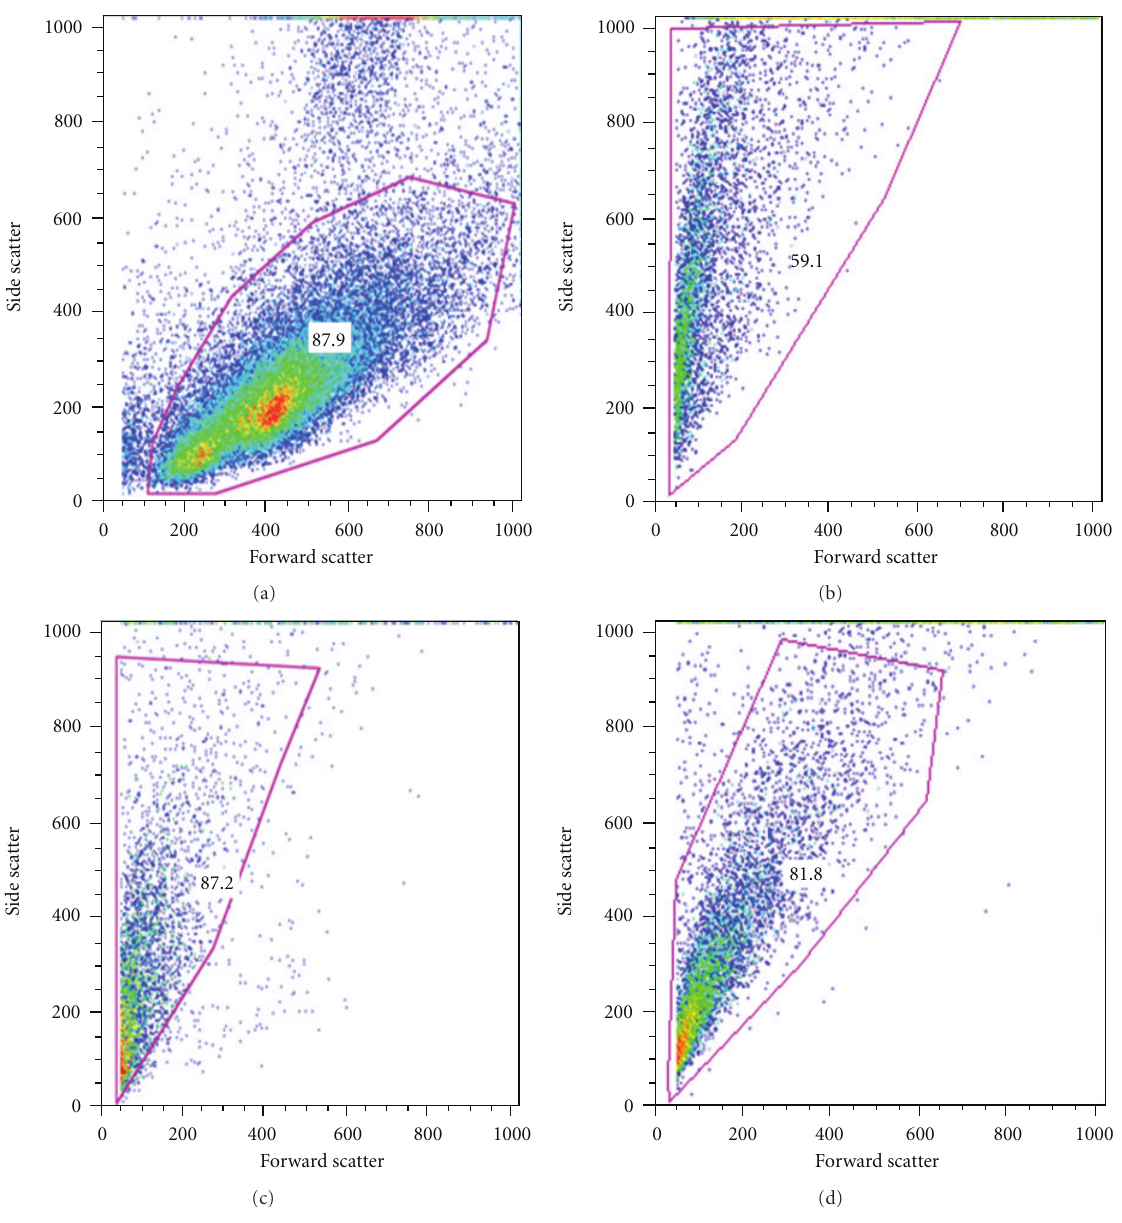
Figure 3: Forward/Side scatter of splenocytes and parasites isolated cells. (a) Spleen cells, (b) T. solium cells, (c) T. crassiceps cells and (d) T. spiralis cells were disaggregated by tissue disruption, washed twice with FC bu ff er, and fixed using Lyse/Fix bu ff er (BD